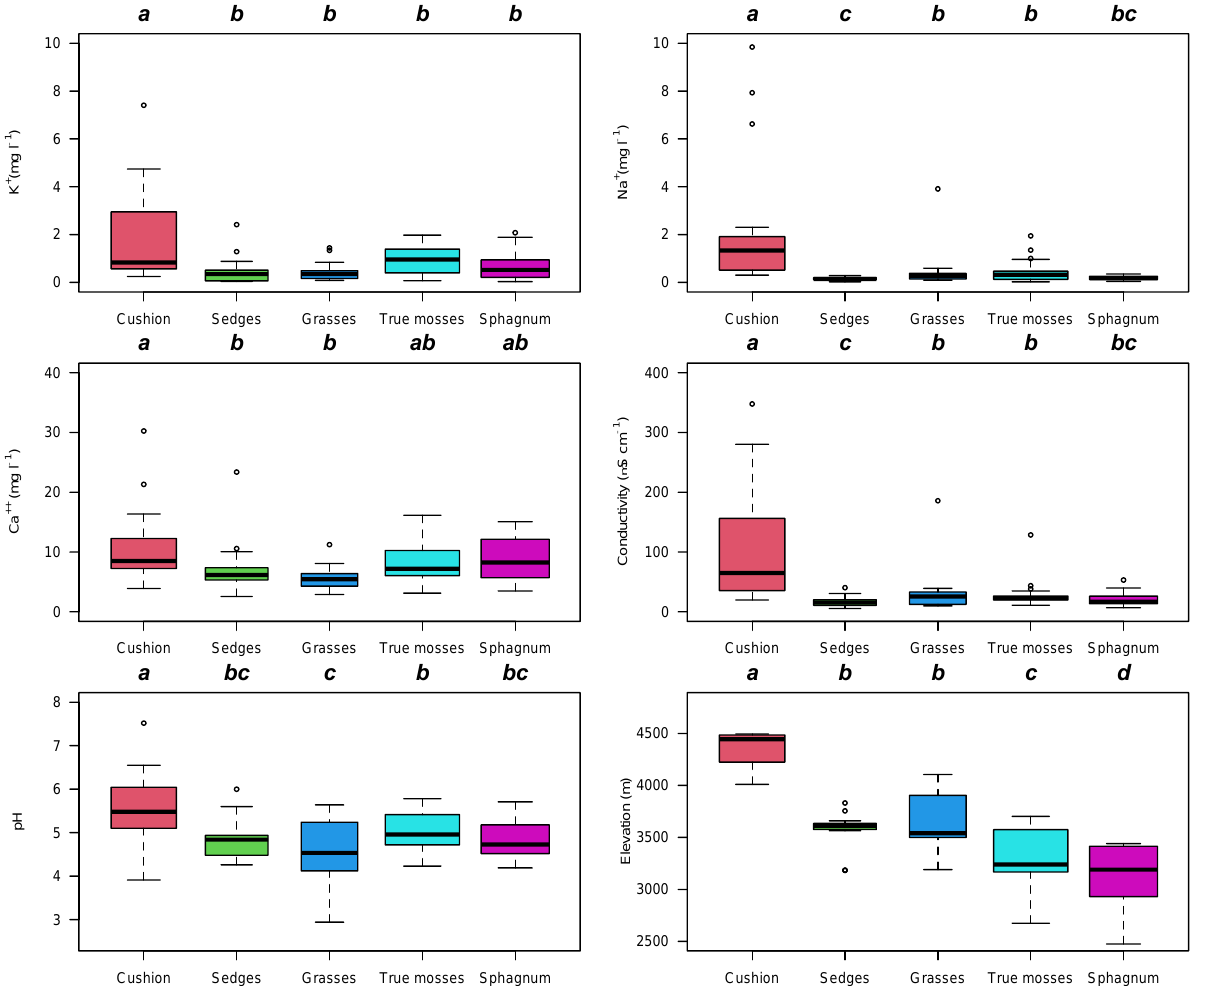
Figure 4. Box and whisker plots for chemistry of pore water variation between the five vegetation types identified in 121 peatlands in the northern Andes. Cation concentrations are presented in mg L −1 . Water electrical conductivity was corrected for [H + ] [37] . Tukey’s homogeneous groups are marked with the same letter. The circles represent outlier values outside the 95% interval.